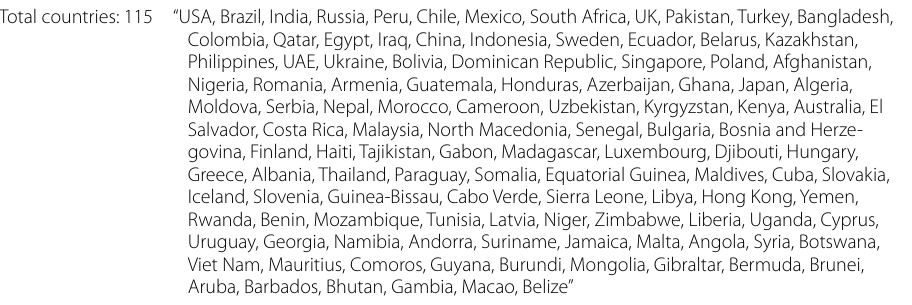
Table 1 List of sample